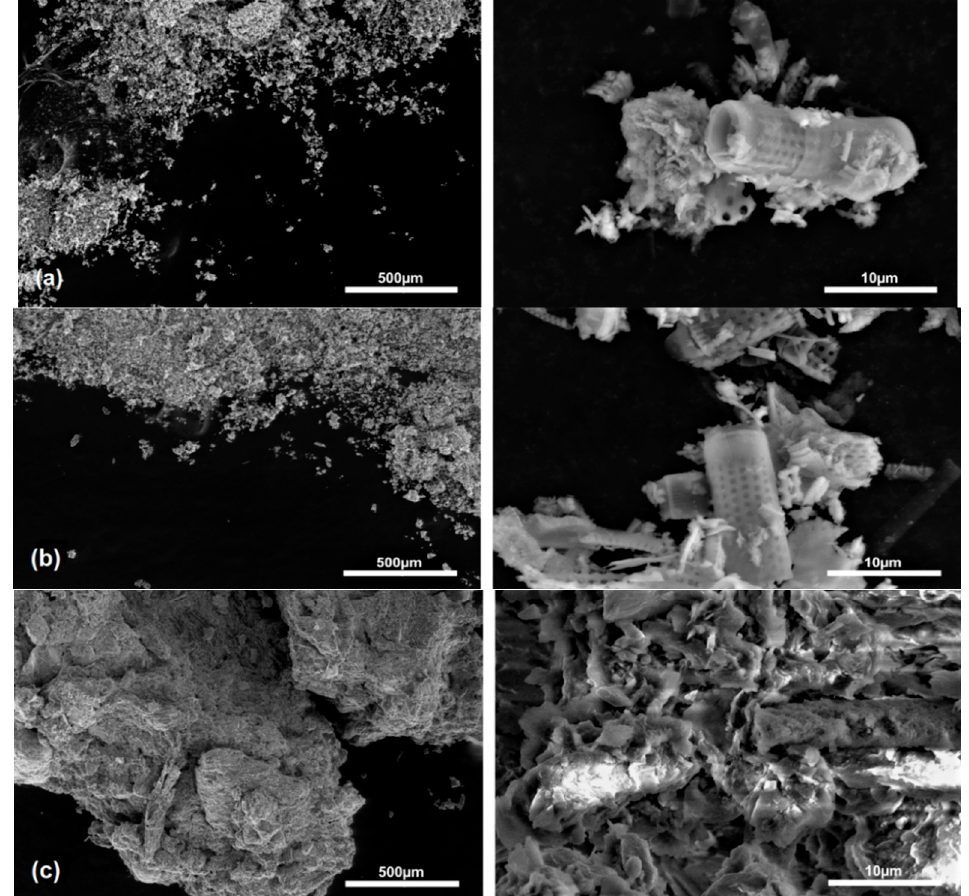
Figure 4. SEM images of ( a ) diatomaceous earth/peat carrier (DEP), ( b ) diatomaceous earth (DE), and ( c ) peat at different magnifications: 500 and 10 µm diameter particles.